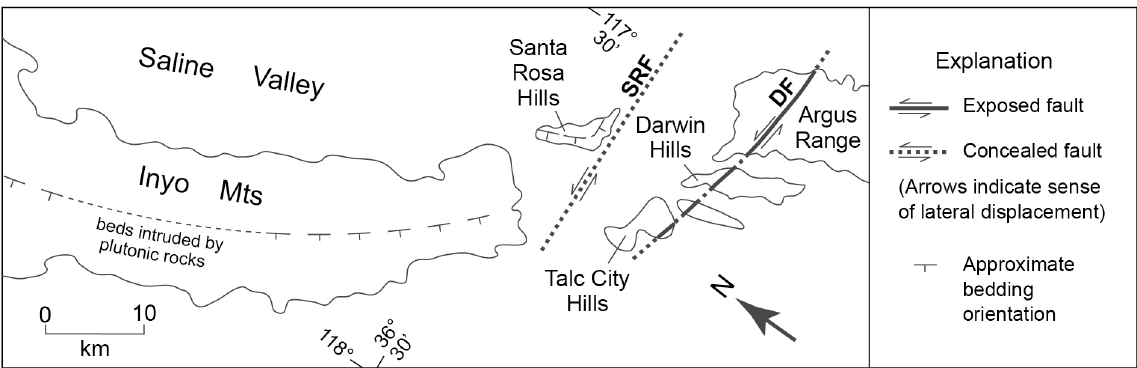
Lake Valley Fault [47,48], suggests the possibility that all of these features (Figures 5 and 9) may be